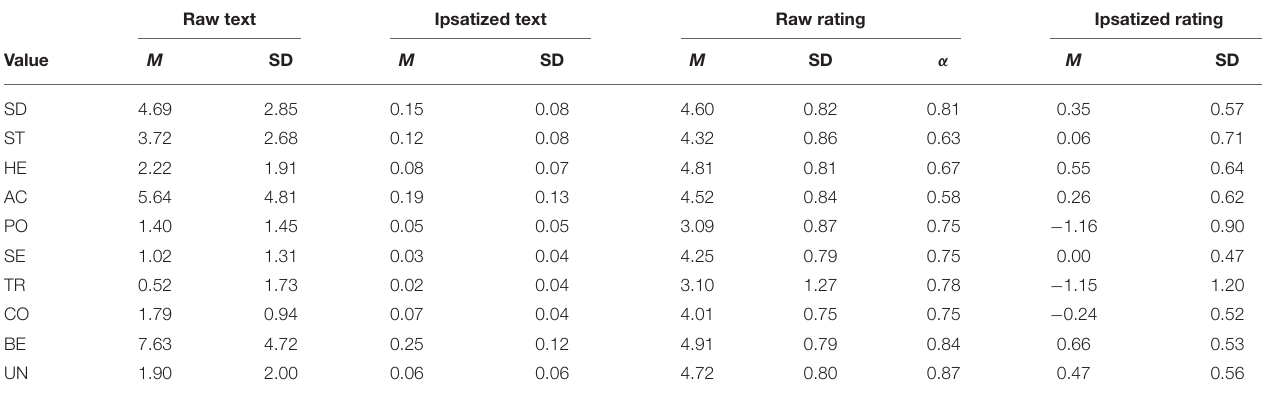
TABLE 1 | Mean scores for the text-based and rating-based value scores. Raw